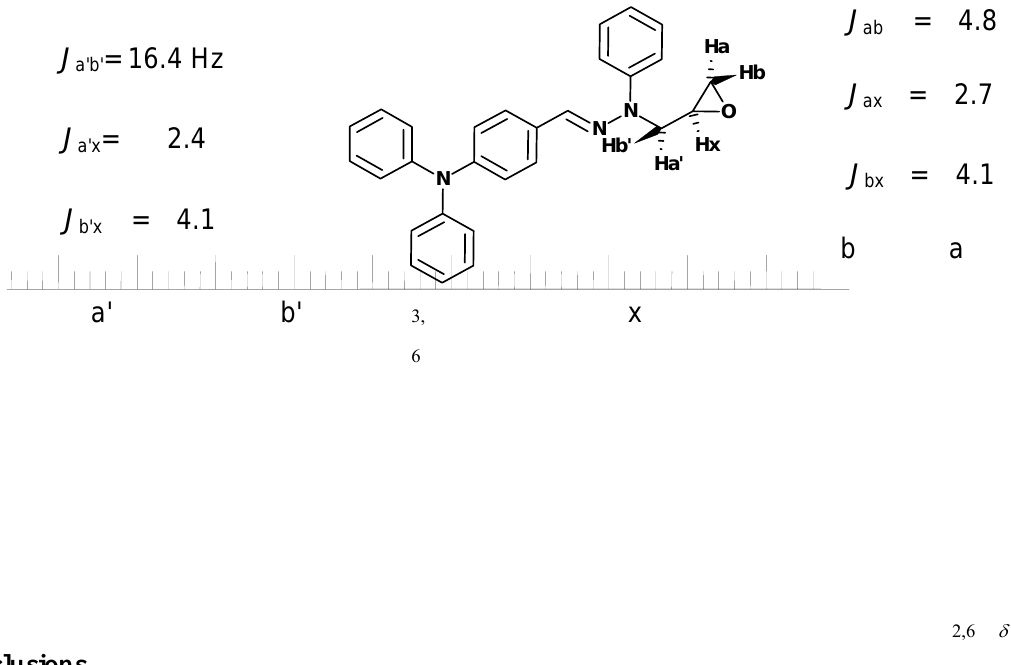
Figure 1. Signals of the 2,3-epoxypropyl group in the 1 H-NMR spectra of 1e (250 MHz, CDCl